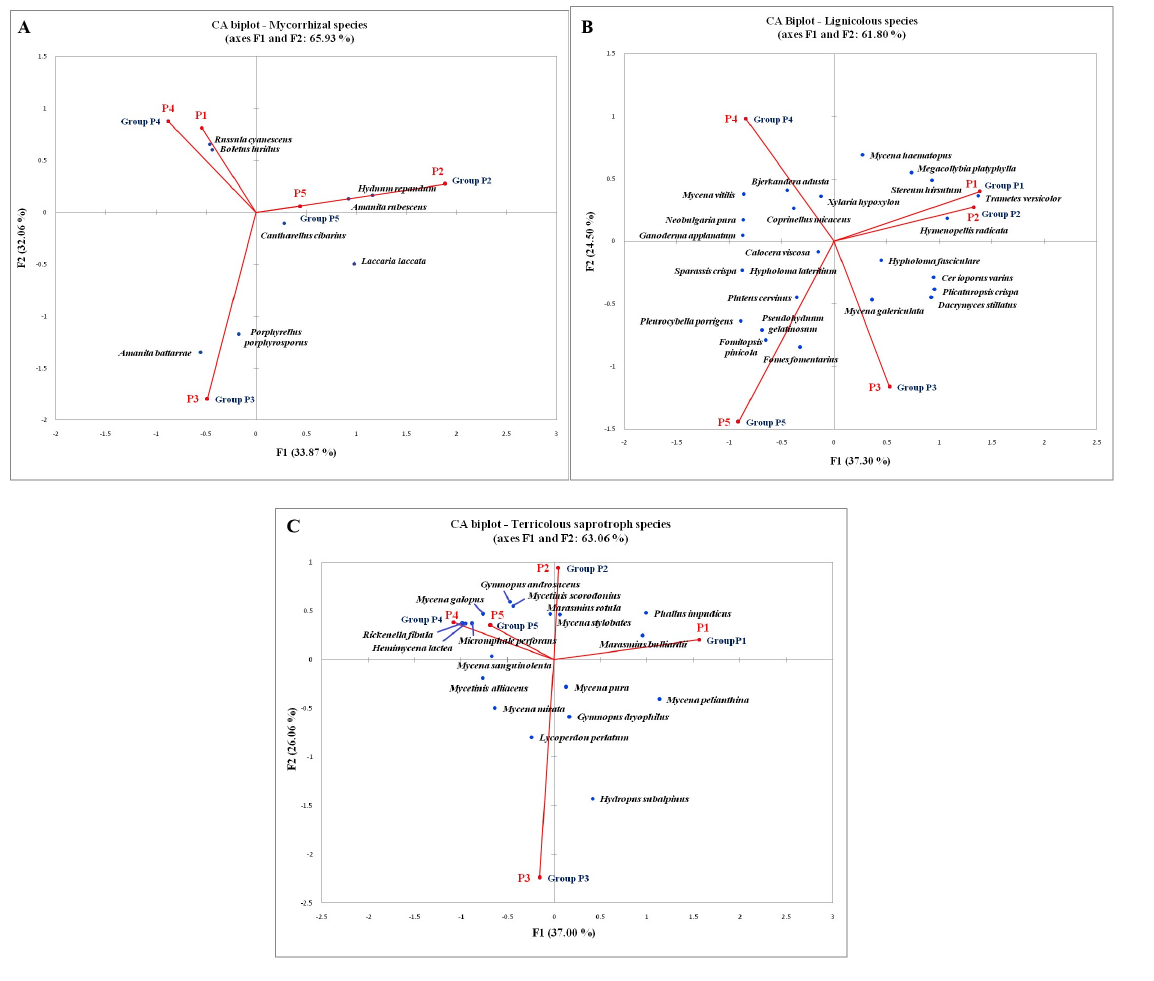
Figure 4. CA analysis of species distribution across studied forest habitats: ( A ) within the mycorrhizal group, ( B ) within the lignocolous group, and ( C ) within the group of terricolous saprotrophs. Legend: dots labeled as Group P1, P2, P3, P4, and P5 represent all the species found only within one specific plot (they are grouped in centrioles that overlap with the points of the corresponding